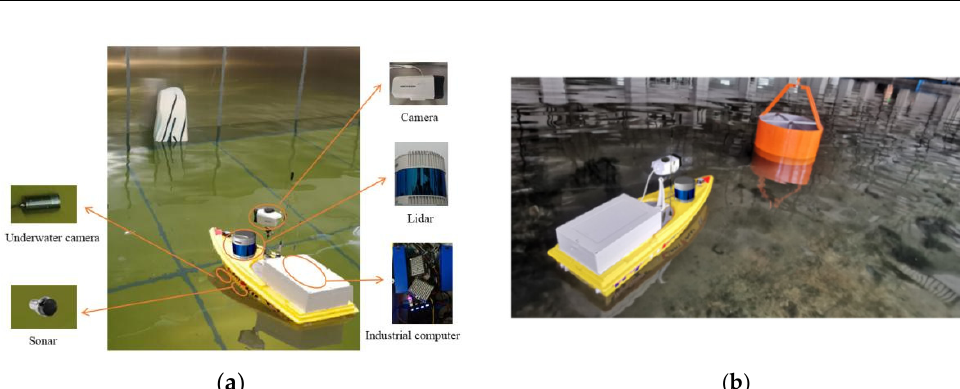
Figure 16. Unmanned ship visual image fusion experimental platform. ( a ) Obstacle 1: iceberg model. ( b ) Obstacle 2: pontoon model.